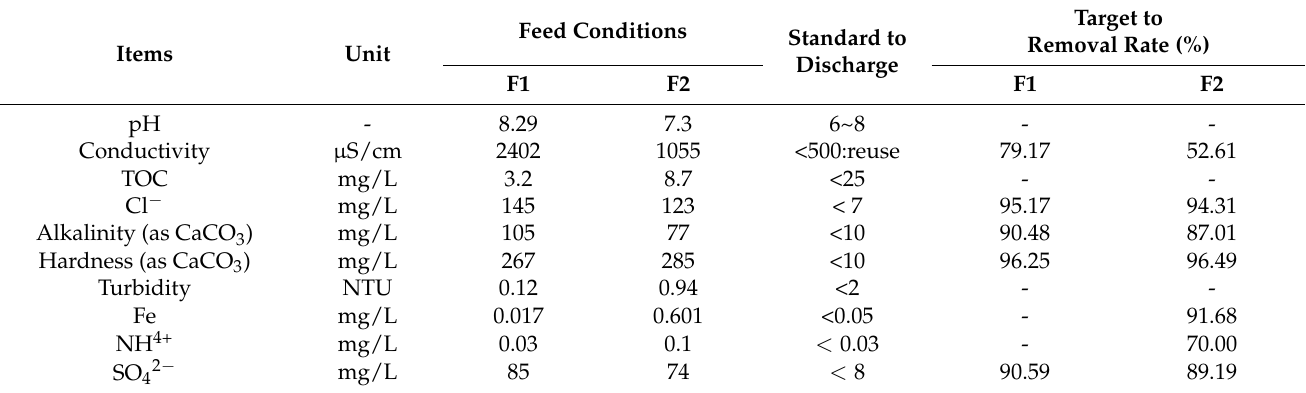
Table 2. The water quality of the wastewater and standards of industrial discharge